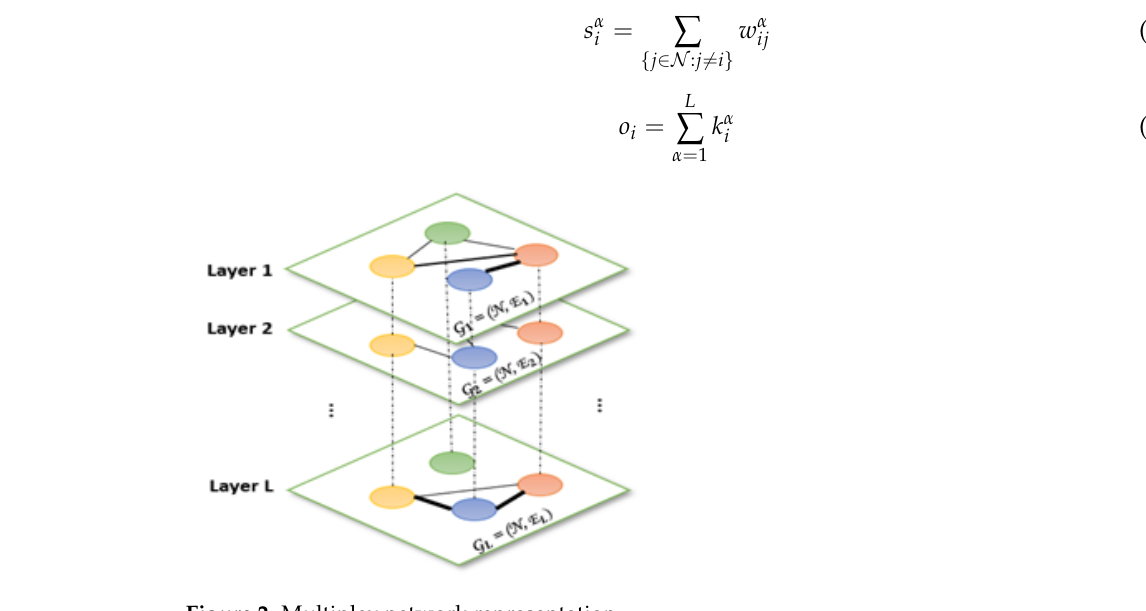
Figure 2. Multiplex network